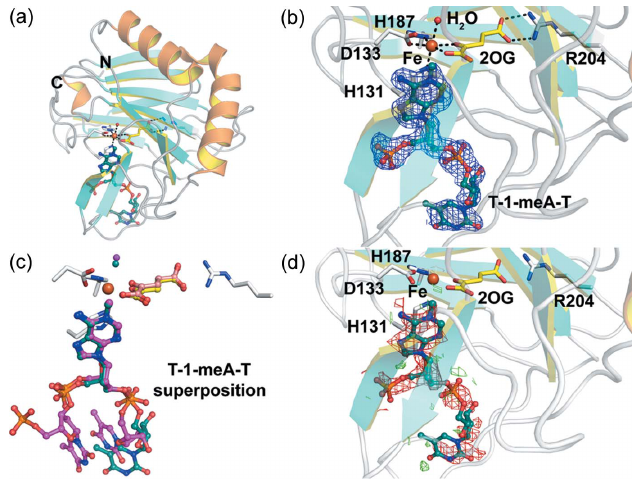
Figure 5 Comparison of the anaerobic and O 2 -exposed AlkB structures. ( a ) Structural overview of the anaerobic AlkB:Fe:2OG:T-1-meA-T complex structure (PDB entry 6y0q, this study). ( b ) Composite omit map to 1.75 A˚ resolution of the active site carved around the methylated DNA fragment displayed at 1.0 (cid:5) contour level. ( c ) Superimposition of the cryogenic AlkB:Fe:2OG:T-1-meA-T complex [magenta and salmon, PDB entry 2fd8 (Yu et al. , 2006)] and the serial RT structure reported here (cyan and yellow, PDB entry 6y0q). ( d ) F obs (cid:3) F obs isomorphous difference maps carved around the methylated DNA fragment contoured at +2.0 (cid:5) (green) and (cid:3) 2.0 (cid:5) (red) for the AlkB:Fe:2OG structure [PDB entry 6ypv (this study)] relative to the AlkB:Fe:2OG:T-1-meA-T structure (PDB entry